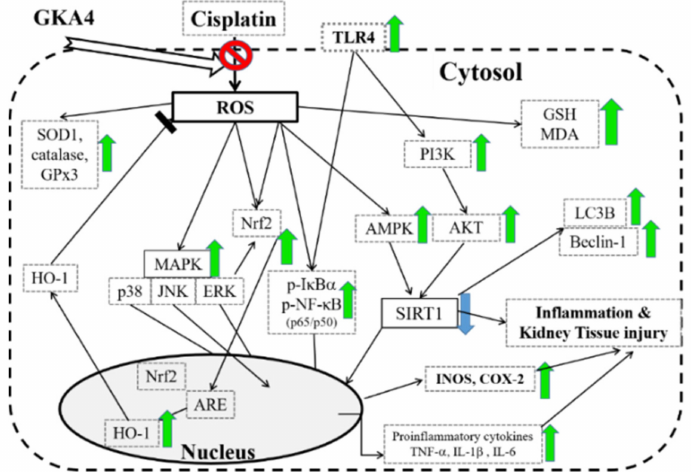
Figure 11. A scheme displaying the protective effect of GKA4 against cisplatin-associated renal injury. The green arrows indicate an increase. The blue arrows indicate a decrease. ROS: reactive oxygen species; MDA: malondialdehyde; GSH: glutathione; MAPK: mitogen-activated protein kinase; JNK: C-jun NH2-terminal kinase; ERK: extracellular-signal-regulated kinase; ARE: antioxidant response element; AP-1: activator protein 1; NF- κ B: nuclear factor of κ B; HO-1: heme oxygenase 1; SOD1: